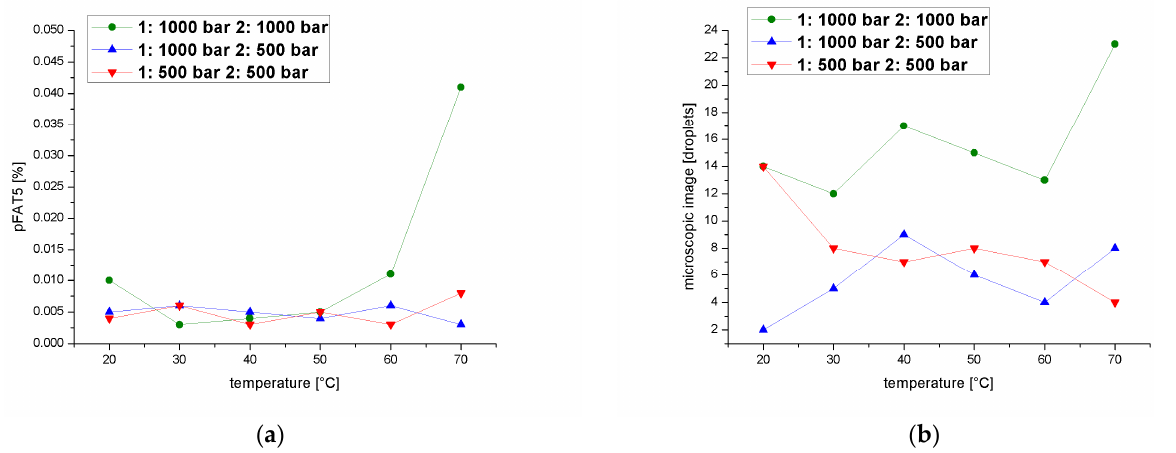
Figure 11. Effect of a two-cycle process with the first cycle at 500 or 1000 bar on the pFAT5 value and droplet counts. ( a ) The pFAT5 value of the second homogenization cycle as a function of temperature at different operating pressures (500–1000 bar). ( b ) The droplet count of the second homogenization cycle as a function of temperature at different operating pressures (500–1000 bar).